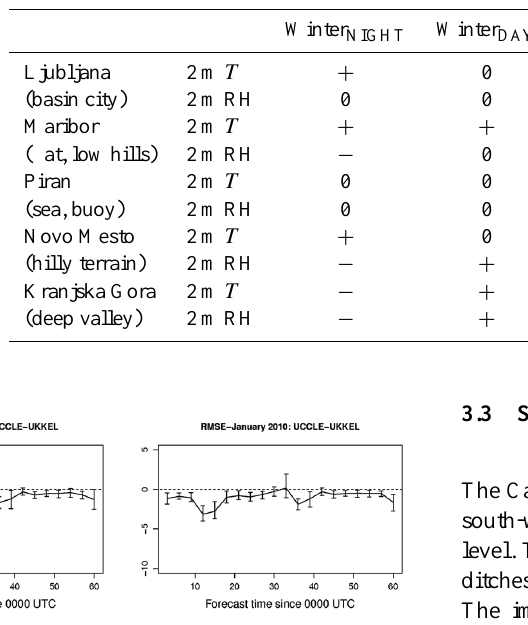
Table 4. The average daytime/night-time scores of 2m temperature (2m T ) and relative humidity (2m RH) of the 4.4km horizontal resolution run for five locations over the Slovenian domain. The + sign means improvement, 0 means neutral effect and the − sign means degradation of the scores.